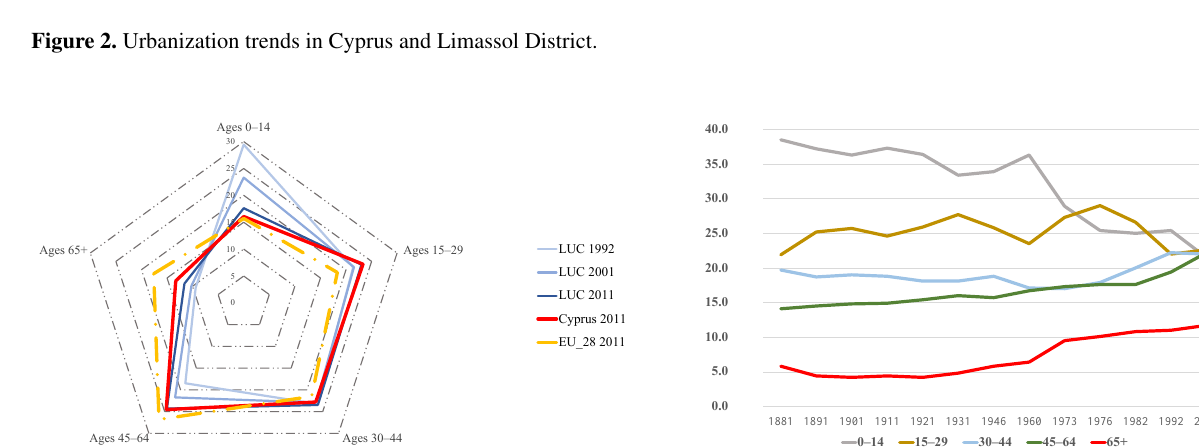
Figure 4. Cyprus age composition structure.